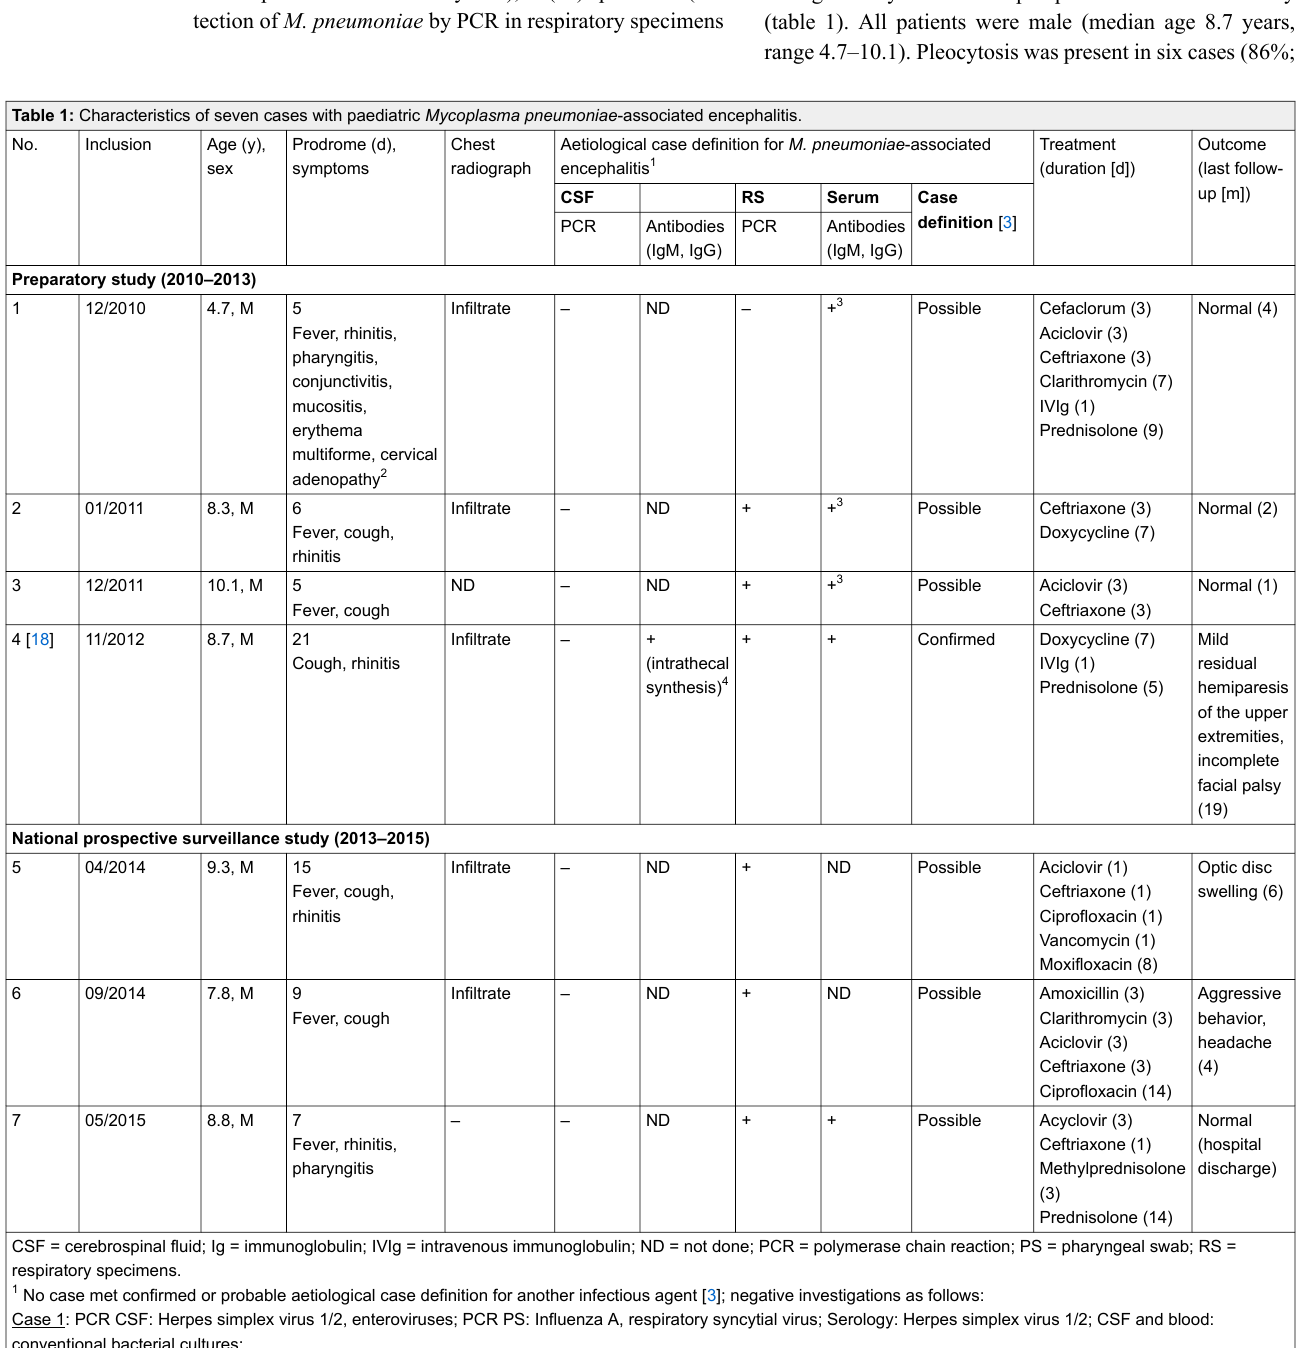
Aetiological case definition for M. pneumoniae -associated encephalitis